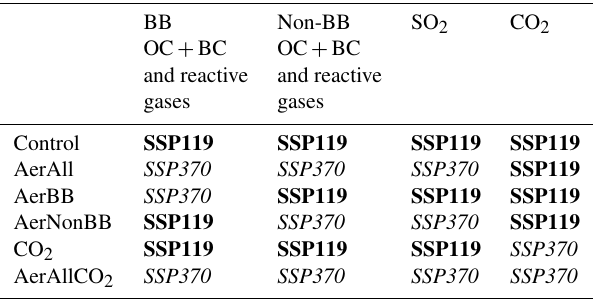
Table 1. The scenario followed for African emissions of aerosols and reactive gases and concentrations of CO 2 in each of the sce- nario experiments. Non-African emissions and concentrations of all species are taken from SSP119 in every experiment. BB: biomass burning, OC: organic carbon, BC: black carbon. Species with SSP119 (SSP370) emissions are in bold (italicised) to add contrast.